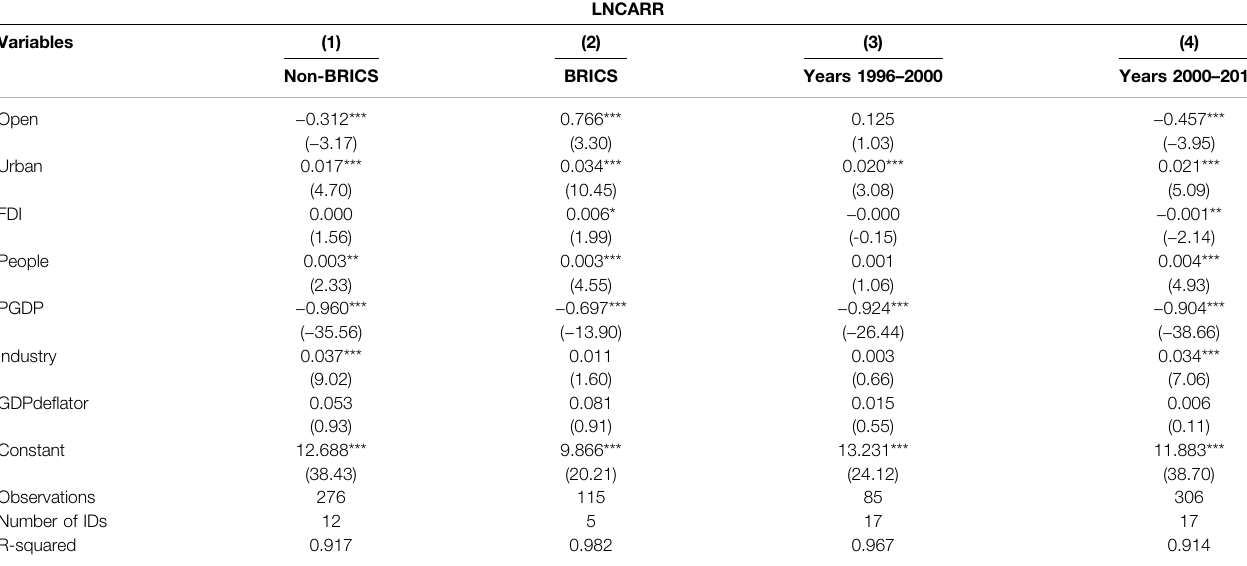
TABLE 7 | Results of the heterogeneity tests.